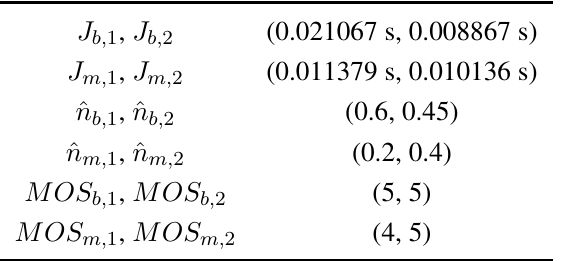
Table 4. Simulation output values for N = 2 users.